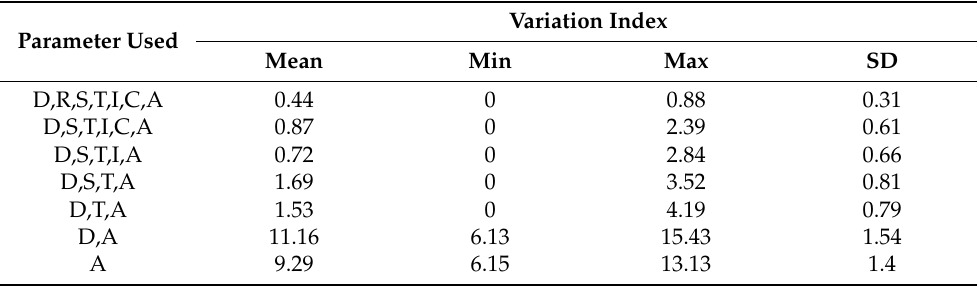
Table 7. Outcomes of the map removal sensitivity analysis after using